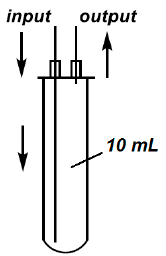
Figure 1. Sketch of the continuous flow system used.